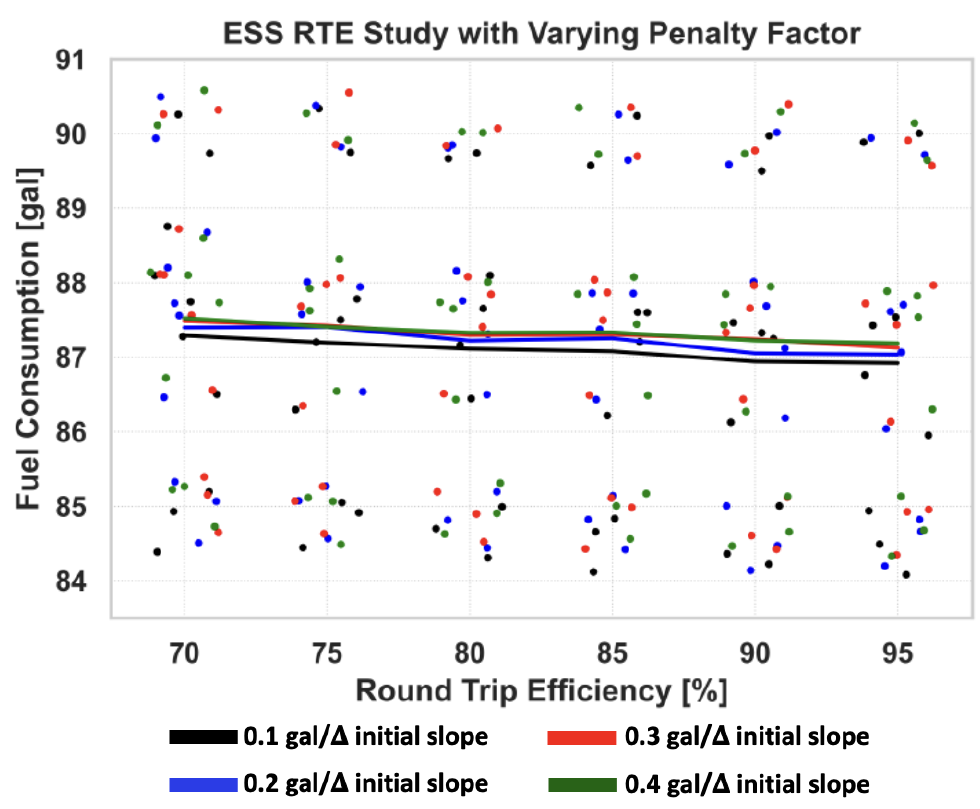
Figure 12. Total fuel consumption for varying ESS RTE and penalty functions for ten different summer demand scenarios. Circular markers indicate individual model runs, while lines indicate average fuel consumption for each ESS RTE and penalty